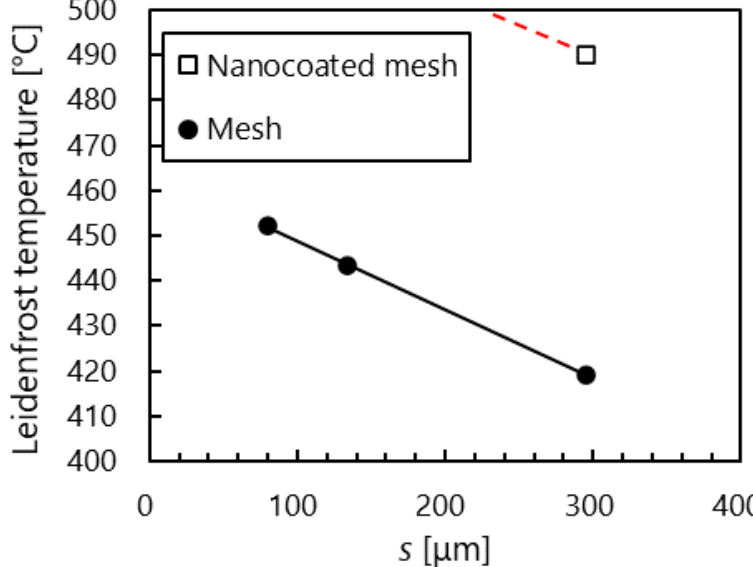
Figure 11. Effect of wire spacing s on the Leidenfrost point (LFP).